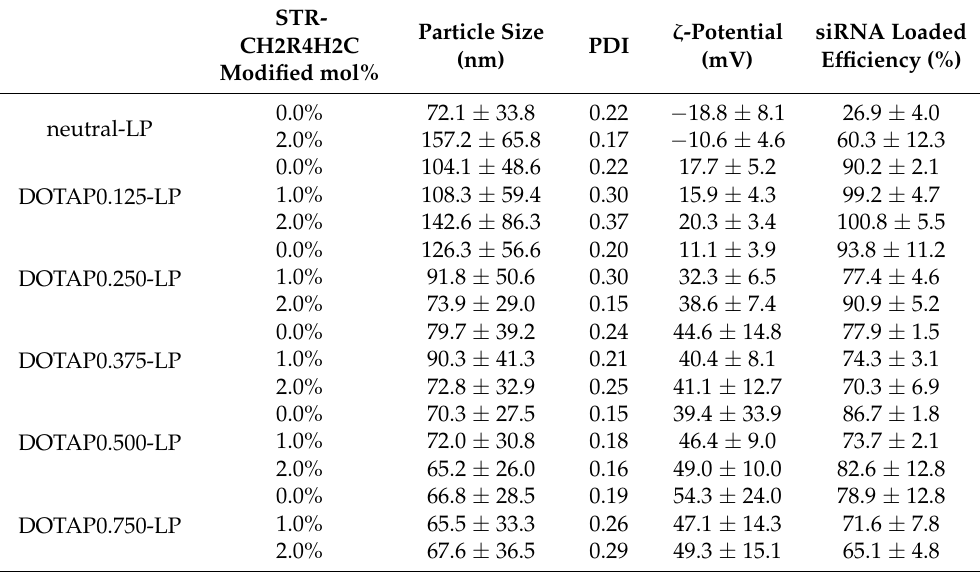
Table 2. Physical properties of STR-CH2R4H2C-LP-siRNA Lipoplexes 1 .